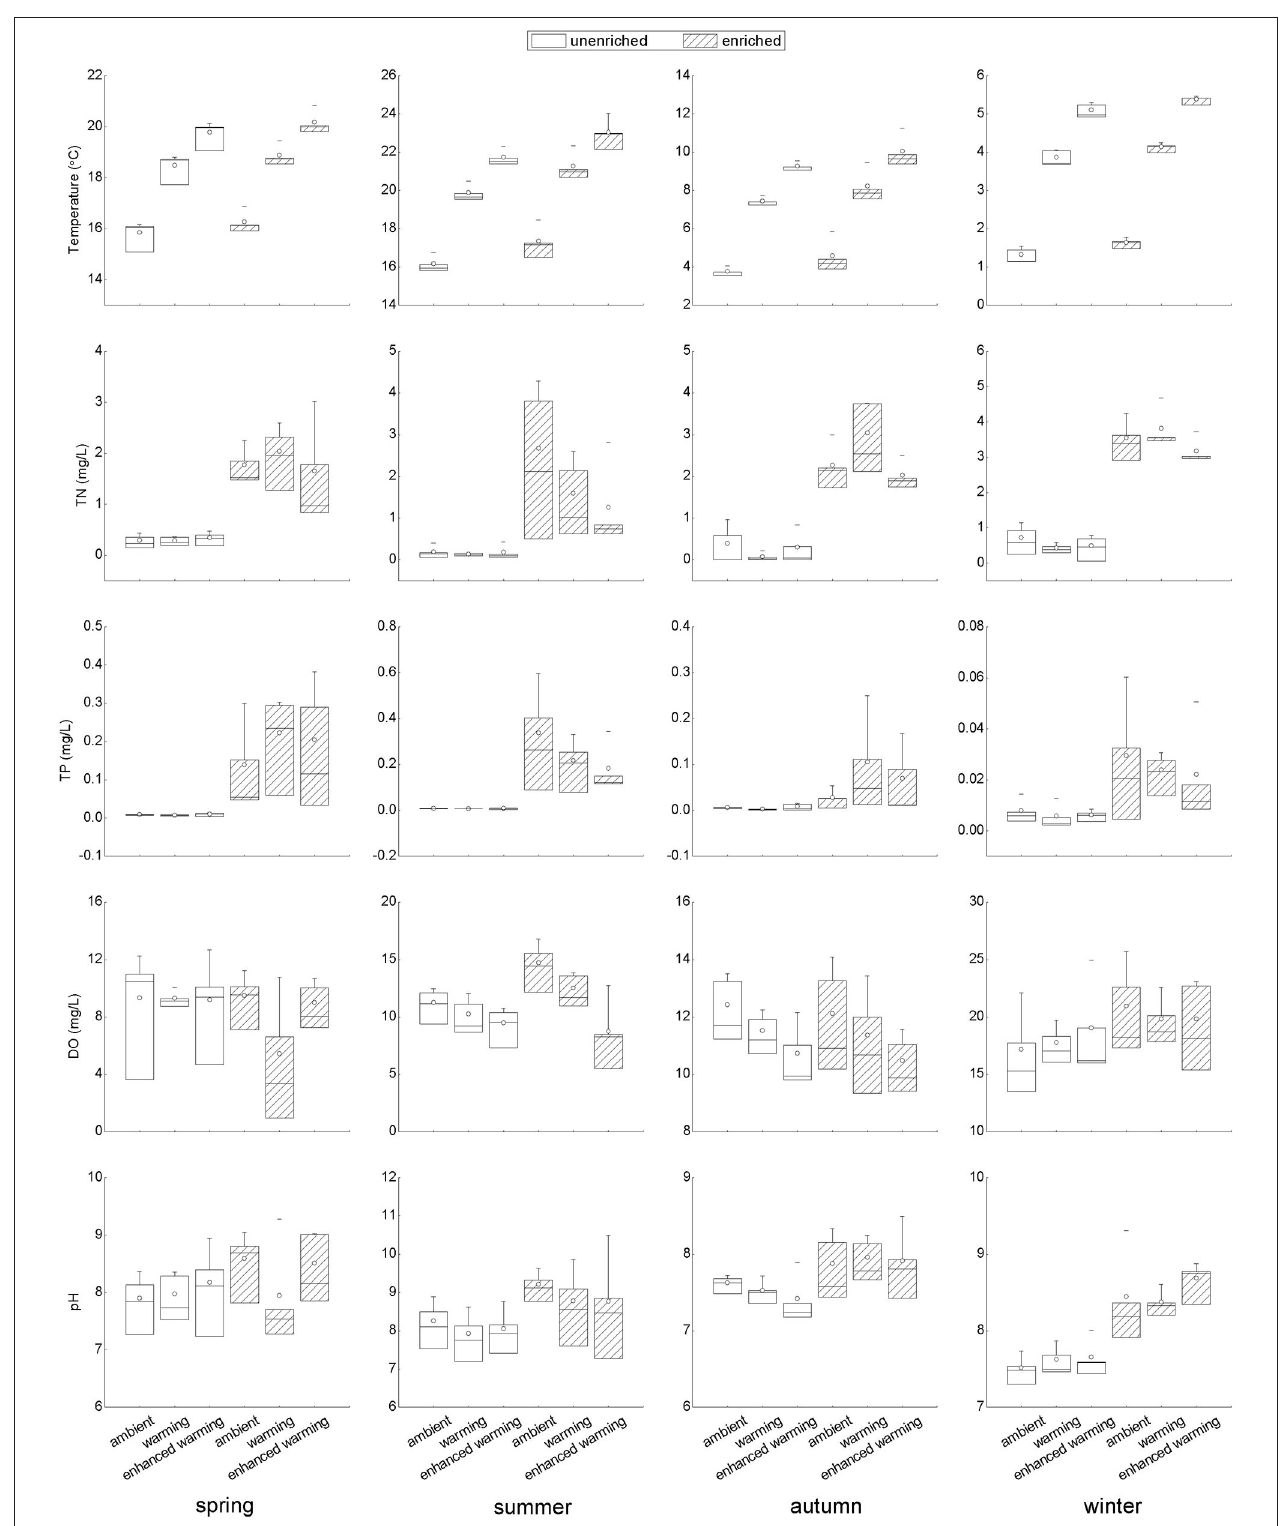
FIGURE 3 | Variation in temperature and nutrient concentrations and responses of abiotic variables to temperature and nutrients in each season. TN, total nitrogen in water; TP, total phosphorus in water; DO, dissolved oxygen.